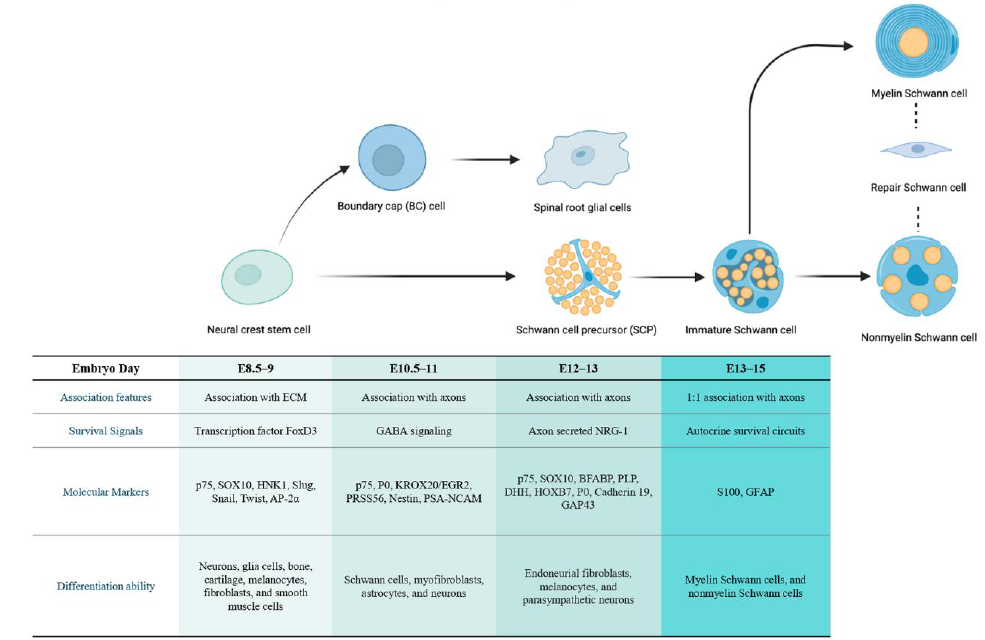
Figure 1. The developmental stage of SC lineage and corresponding characteristics of different cell types. Neural crest stem cells (NCSCs) can differentiate into multipotent boundary cap (BC) cells and SC precursors (SCPs). The SCPs further develop into immature SCs, which then differentiate